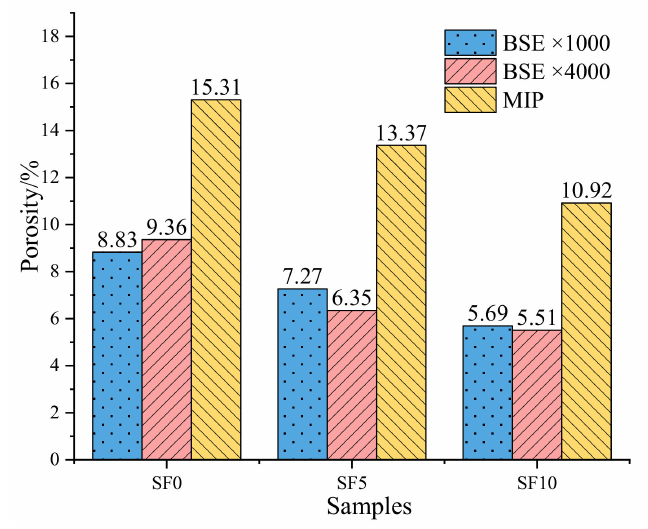
Figure 7. Porosity of mortar samples obtained by different